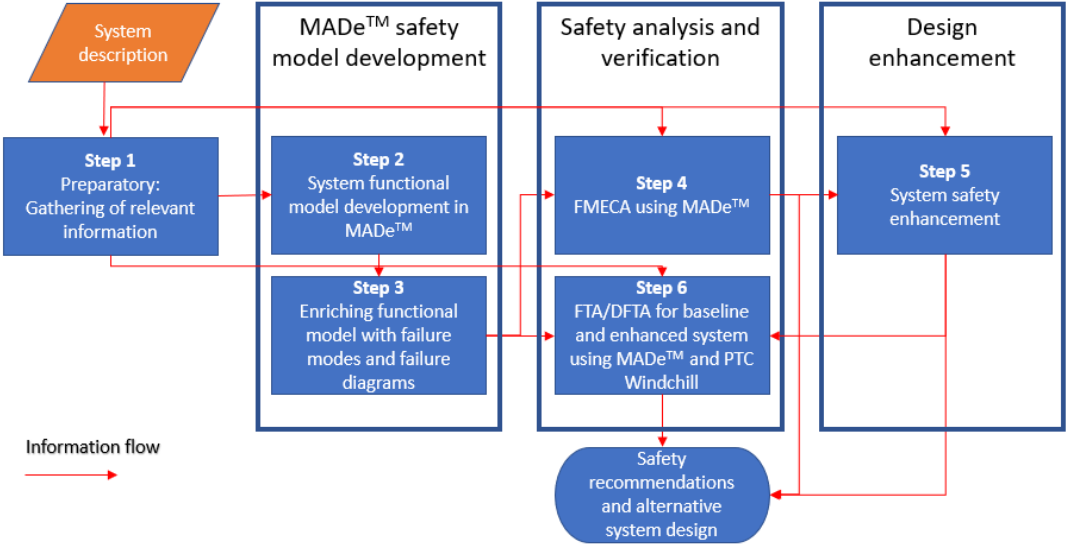
Figure 1. Methodology flowchart.